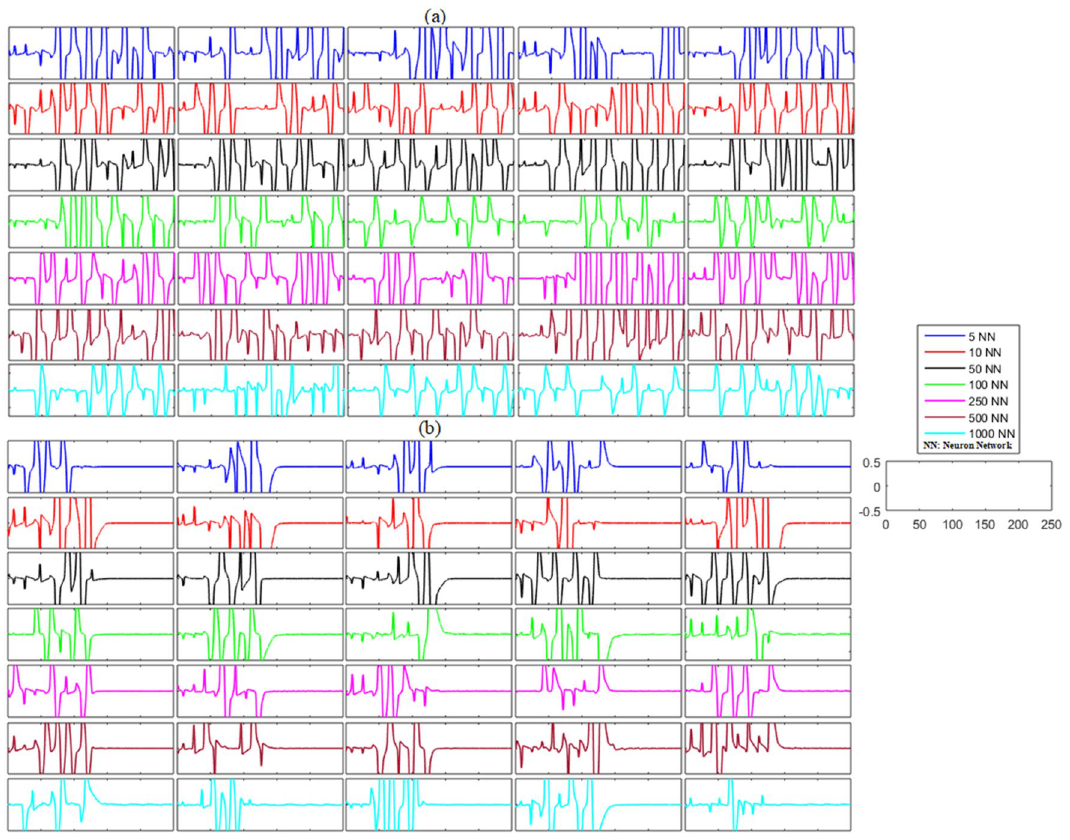
Figure 5. ( a ) Without control synchronization dynamics of the recovery variable states (y-states) of different time-delayed unidirectional FHN networks with noise. ( b ) Controlled synchronized error dynamics of the recovery variable states (y-states) of different time-delayed unidirectional FHN neuronal networks with noise. Number of neurons in